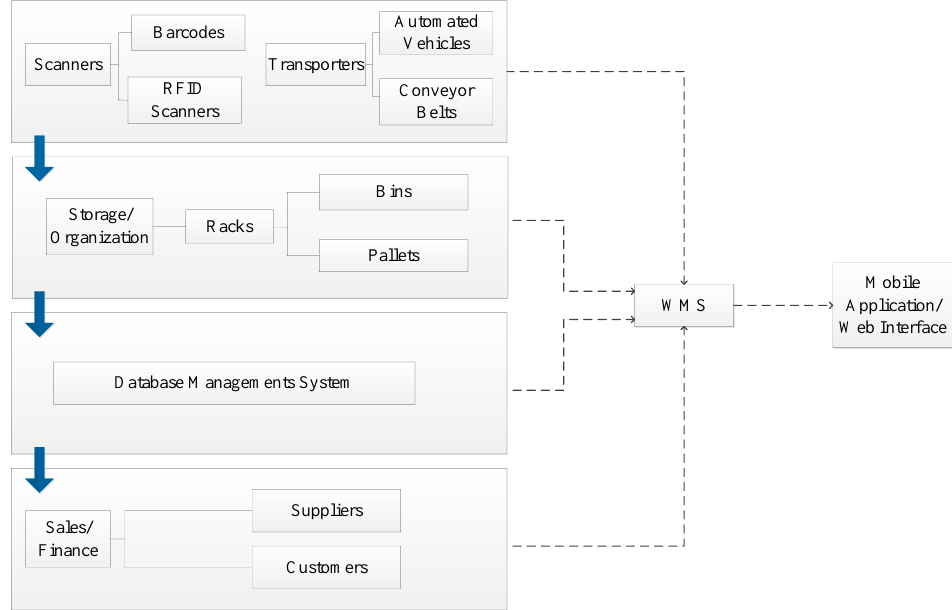
Figure 3. Functional